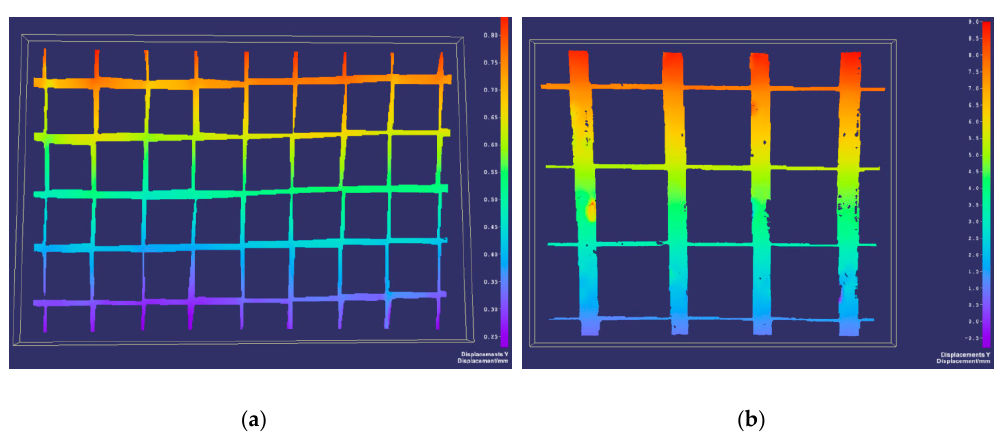
Figure 19. Vertical strains of biaxial geogrids: ( a ) Maps of the distribution of vertical strains on the surface of the glass fibre geogrid sample; ( b ) maps of the distribution of vertical strains on the surface of the polyester geogrid sample [52].